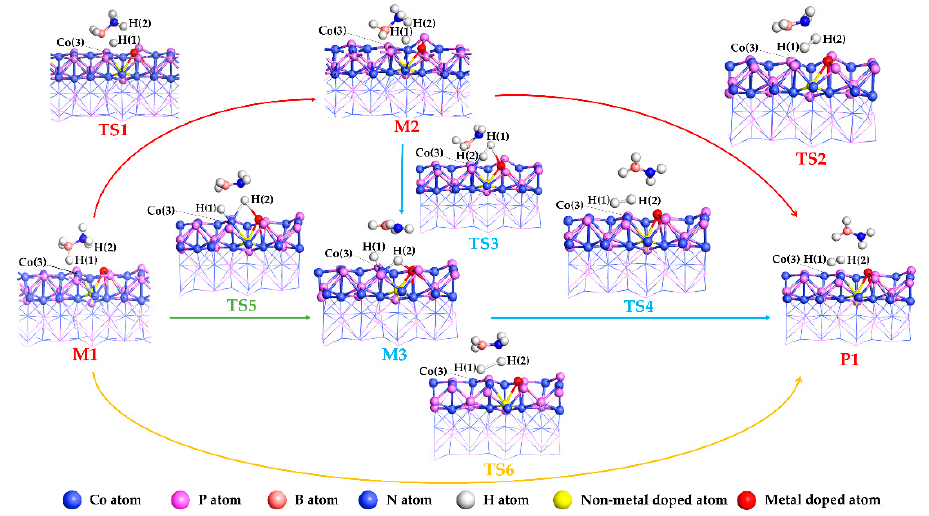
Figure 3. Mechanism of hydrogen evolution reaction of NH 3 BH 3 .